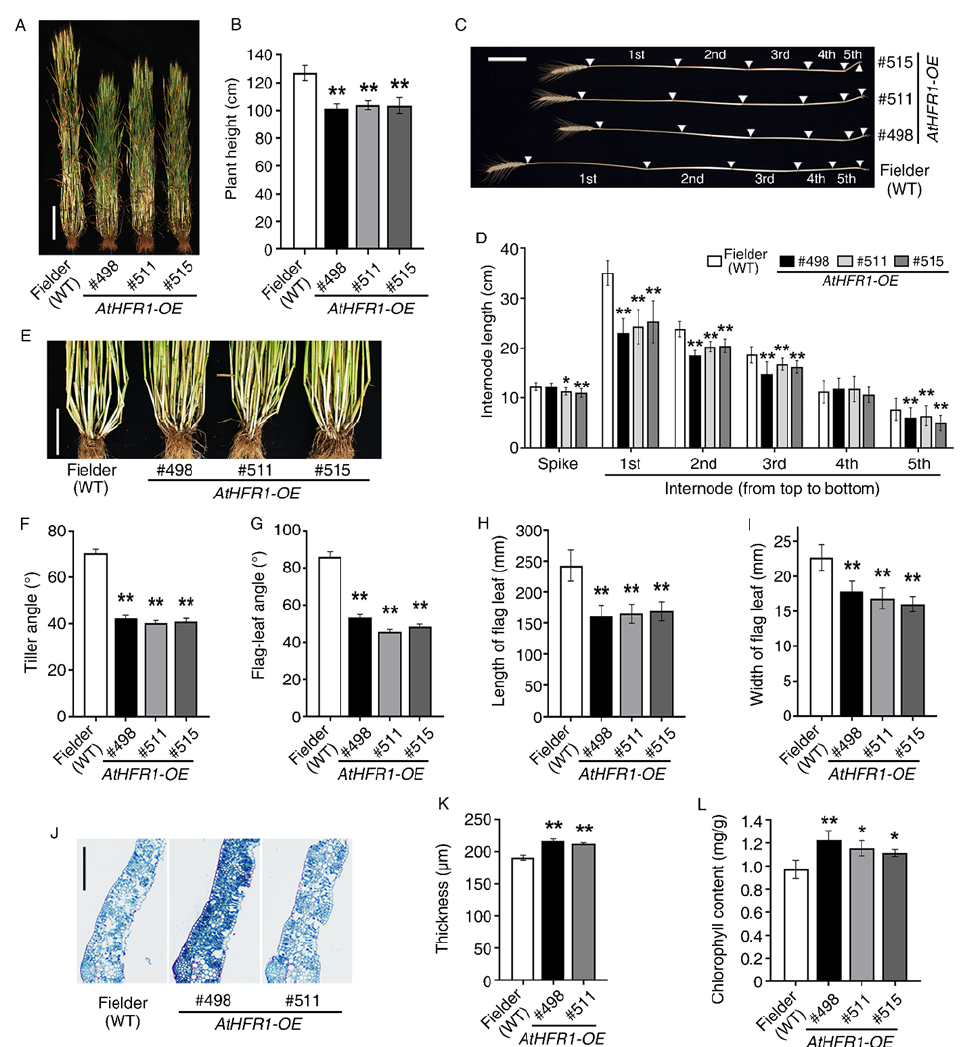
Figure 3. The AtHFR1 transgene leads to better plant architecture in the field: ( A ) Morphology of the WT (cv. Fielder) and AtHFR1 transgenic lines (#498, #511, and #515) at the late filling stage (238 days after sowing). Bar = 20 cm. ( B ) Plant height of the WT and AtHFR1 transgenic lines (#498, #511, and #515). Data are means ± SDs, n ≥ 40. Plant internode morphology ( C ) and internode length ( D ) of the WT and AtHFR1 transgenic lines (#498, #511, and #515). White triangles indicate nodes, and the distances between each pair of nodes are internode lengths (1st to 5th). Bar = 10 cm. Data are means ± SDs, n ≥ 35. Tiller morphology ( E ) and tiller angle ( F ) of the WT and AtHFR1 transgenic lines (#498, #511, and #515) at the late filling stage. Bar = 10 cm. The angle between the tiller and vertical was recorded as the tiller angle. Data are means ± standard errors (SEs), n ≥ 50. ( G ) Flag-leaf angle of transgenic lines. The angle between the flag leaf and vertical was recorded as the flag-leaf angle. Data are means ± SEs, n ≥ 130. Length ( H ) and width ( I ) of the flag leaf of the WT and AtHFR1 transgenic lines (#498 and #511). The length between the pulvinus and tip was recorded as the leaf length, and the width at the middle of the leaf was measured as the leaf width. Data are means ± SDs, n ≥ 85 ( J , K ). Flag leaf thickness of the WT and AtHFR1 transgenic lines (#498 and #511). The thickness of the flag leaf at the filling stage was measured through slice analysis. Bar = 250 μm. ( L ) Flag leaf chlorophyll contents of the WT and AtHFR1 transgenic lines (#498, #511, and #515) at the jointing stage (148 days after sowing). Data are means ± SDs, n = 5. Asterisks denote significant differences in #498, #511, or #515 with Fielder according to ANOVA (* p < 0.05; ** p < 0.01).